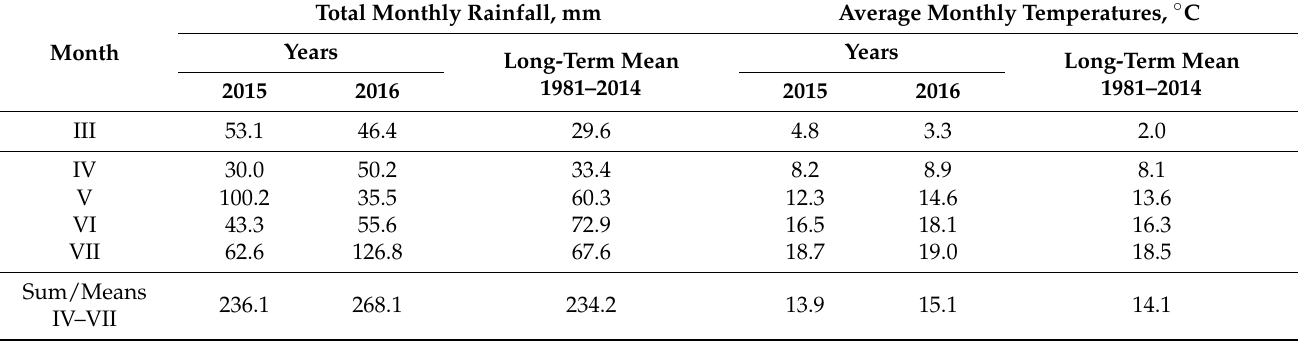
Table 2. Rainfall and air temperatures in 2015 and 2016, (Institute of Meteorology and Water Manage- ment, National Research Institute in